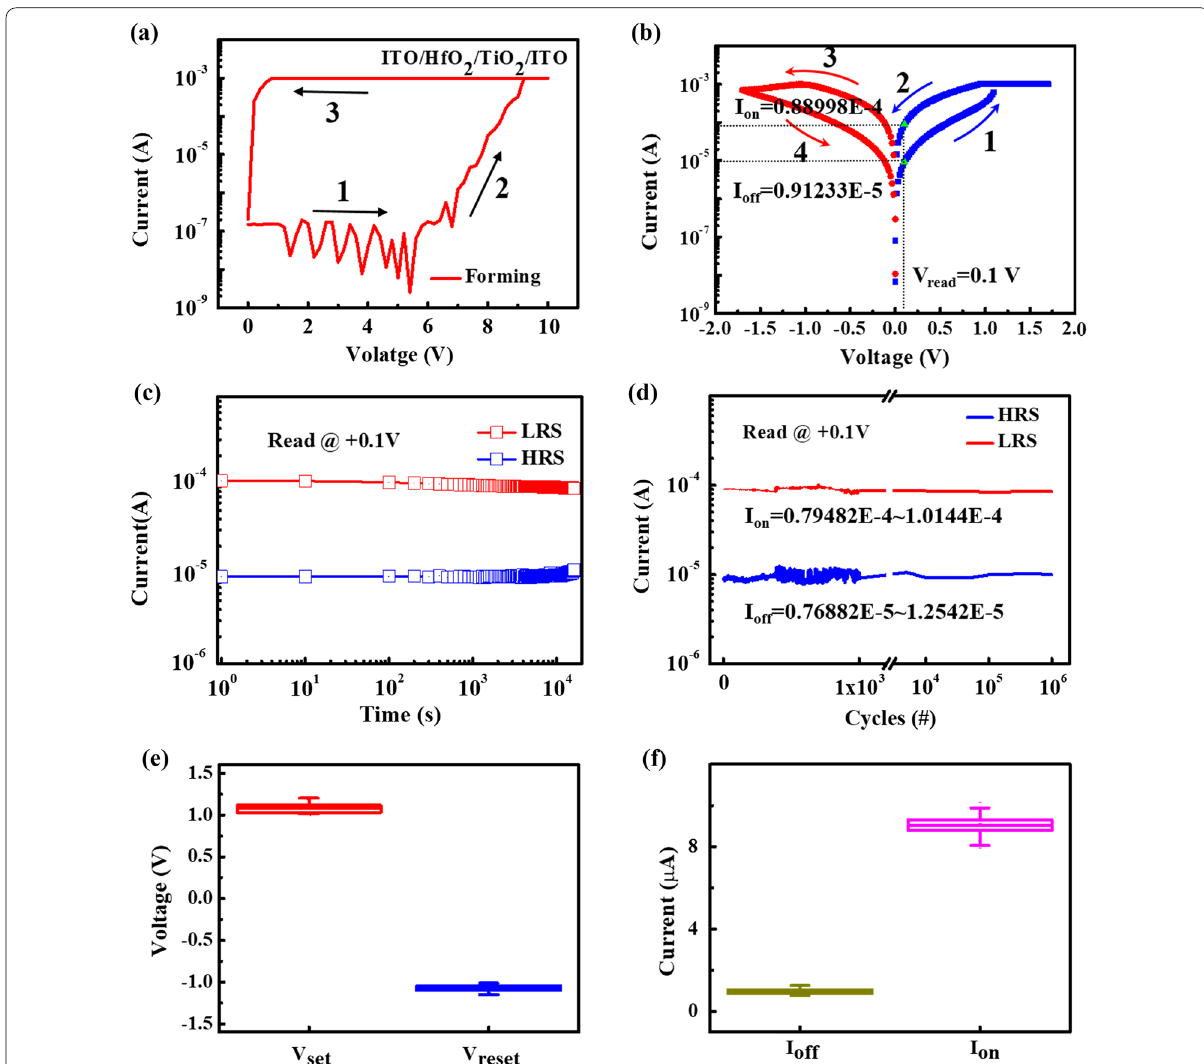
Fig. 2 a Electroforming process of the device. b I–V curve. c Retention of the device at room temperature. d Endurance plot. e Set and reset voltage distributions. f On and off current